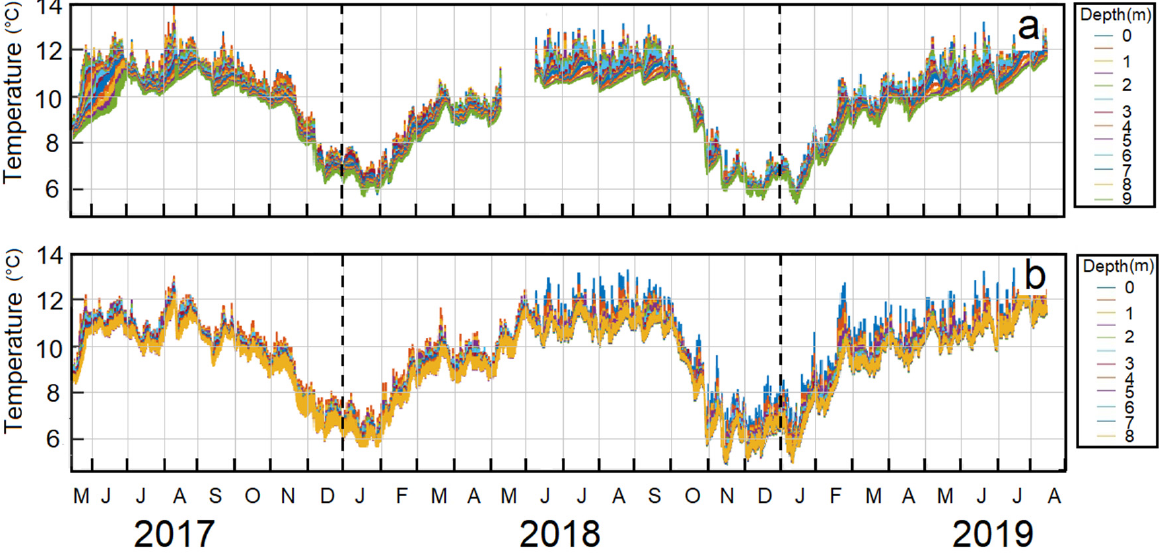
Figure 4. Hourly variability of temperature ( a ) at thirteen depths of Lake El Sol ( a ) and at twelve depths of Lake La Luna ( b ) for the same time period (instrumental depths are indicated in the leg- end).